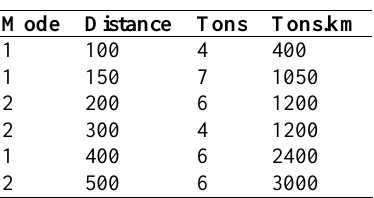
Table 5. Input data for simple